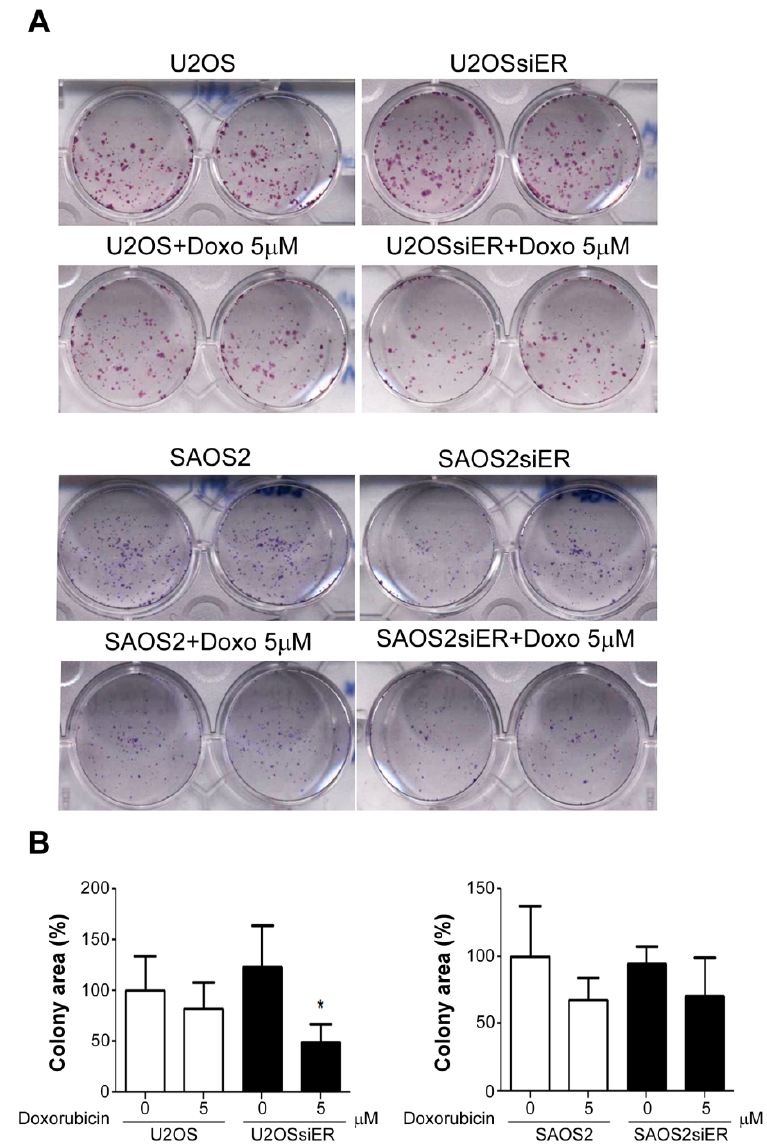
Figure 4. Silencing of ER α in P53-positive U2OS cells suppressed colony formation abilities after treatment with doxorubicin. ( A ) The cells were seeded at 1000 cells/well in a 6-well plate and incubated for 7 days, followed by crystal violet staining. Groups of more than 250 cells were stained blue. ( B ) The total colony area was quantified by ImageJ software, and * p < 0.05 was considered to be a significant difference.